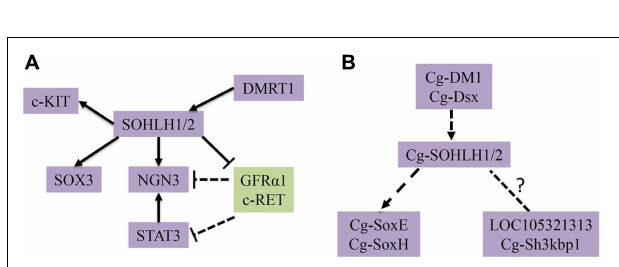
FIGURE 6 | Immunohistochemistry of SOHLH1 protein in the male gonads of oysters. (A) 200 × magnification. (B) 400 × magnification. 1, growth stage; 2, maturation stage; 3, resting stage; 4, maturation stage control; Fc, follicular cell; Sg, spermatogonia; Sc, spermatocyte; Sz, spermatozoa.